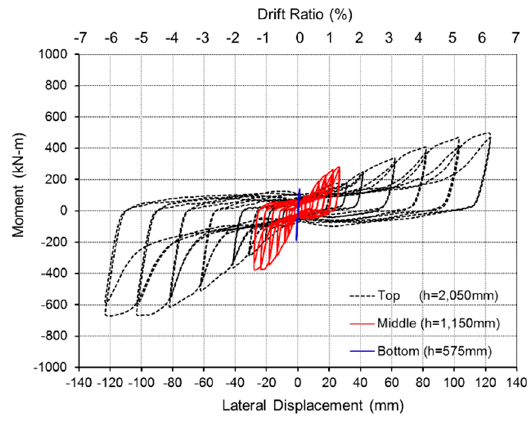
Figure 26. Load–displacement hysteresis curve of SP-S.